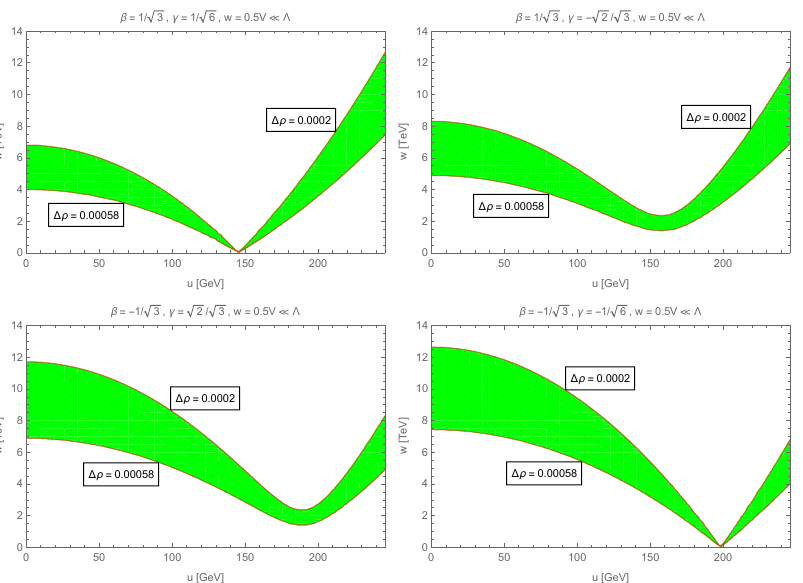
Figure 1 . The ( u, w ) regime that is bounded by the ρ parameter for w = 0 . 5 V panels from left to right and top to bottom correspond to the four dark matter models.